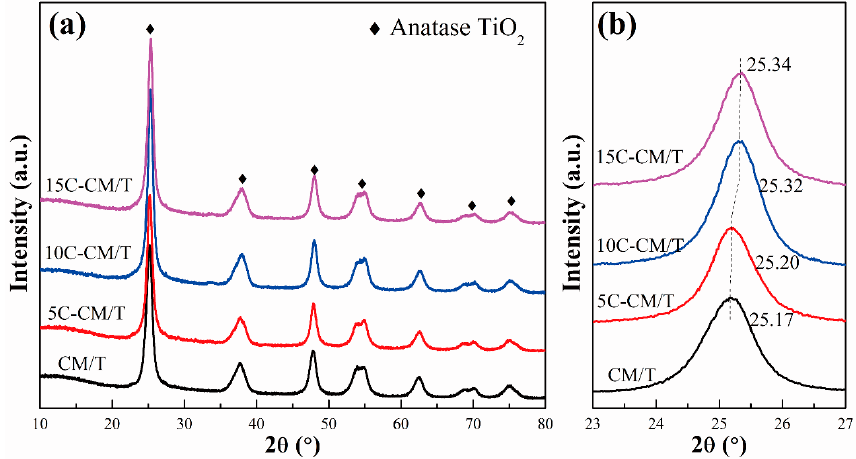
Figure 2. ( a ) X-ray diffraction patterns of CM/T, 5C-CM/T, 10C-CM/T and 15C-CM/T; ( b ) Zoomed XRD patterns.